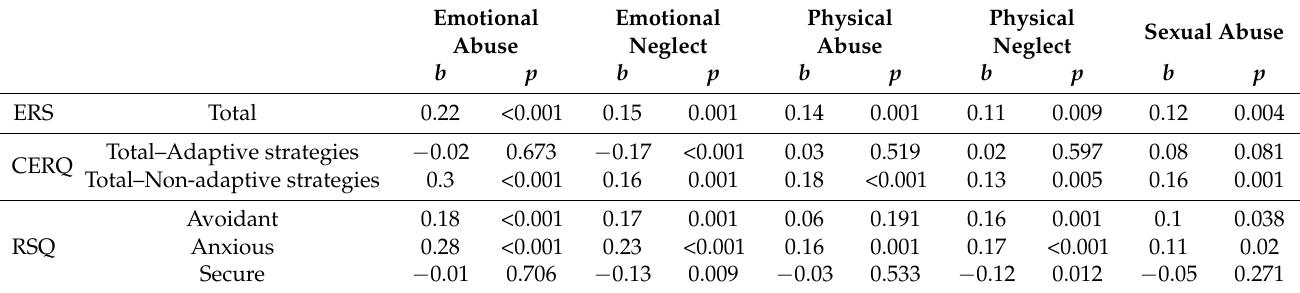
Table 3. Effect of different types of childhood maltreatment on ERS total score, CERQ adaptive and non-adaptive strategies total scores, and RSQ avoidant, anxious, and secure